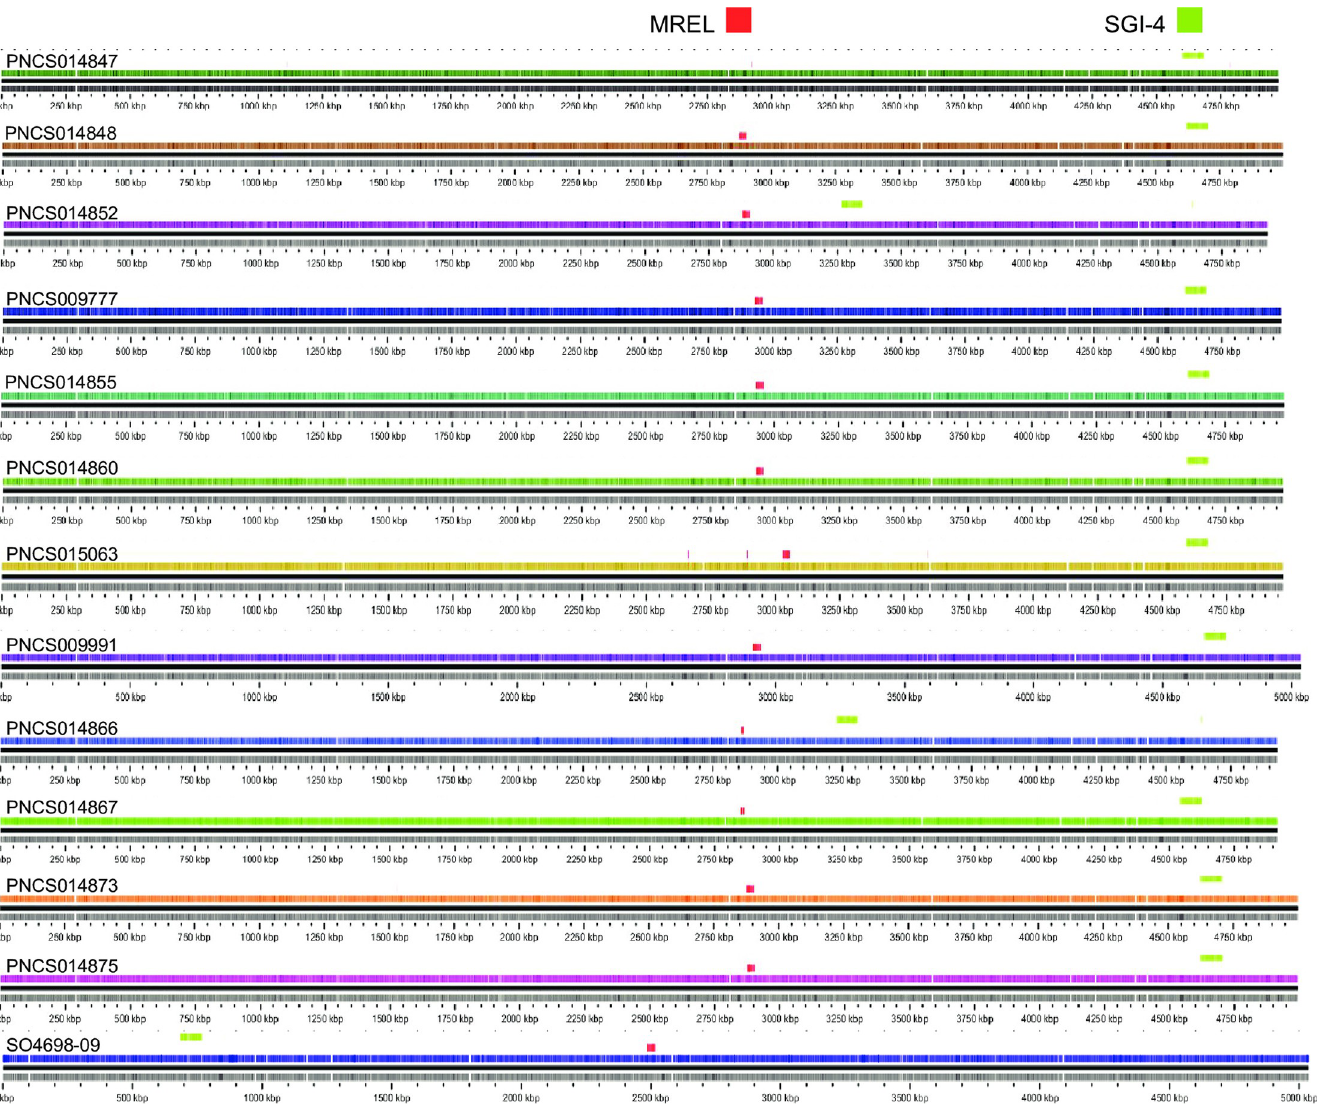
Fig 1. Location of the mercury resistance element MREL and SGI-4 within closed genome sequences. The comparison was done using GView Server as four separate “BLAST atlas” analyses and the resulting image files were assembled and annotated in Adobe Illustrator CS6.